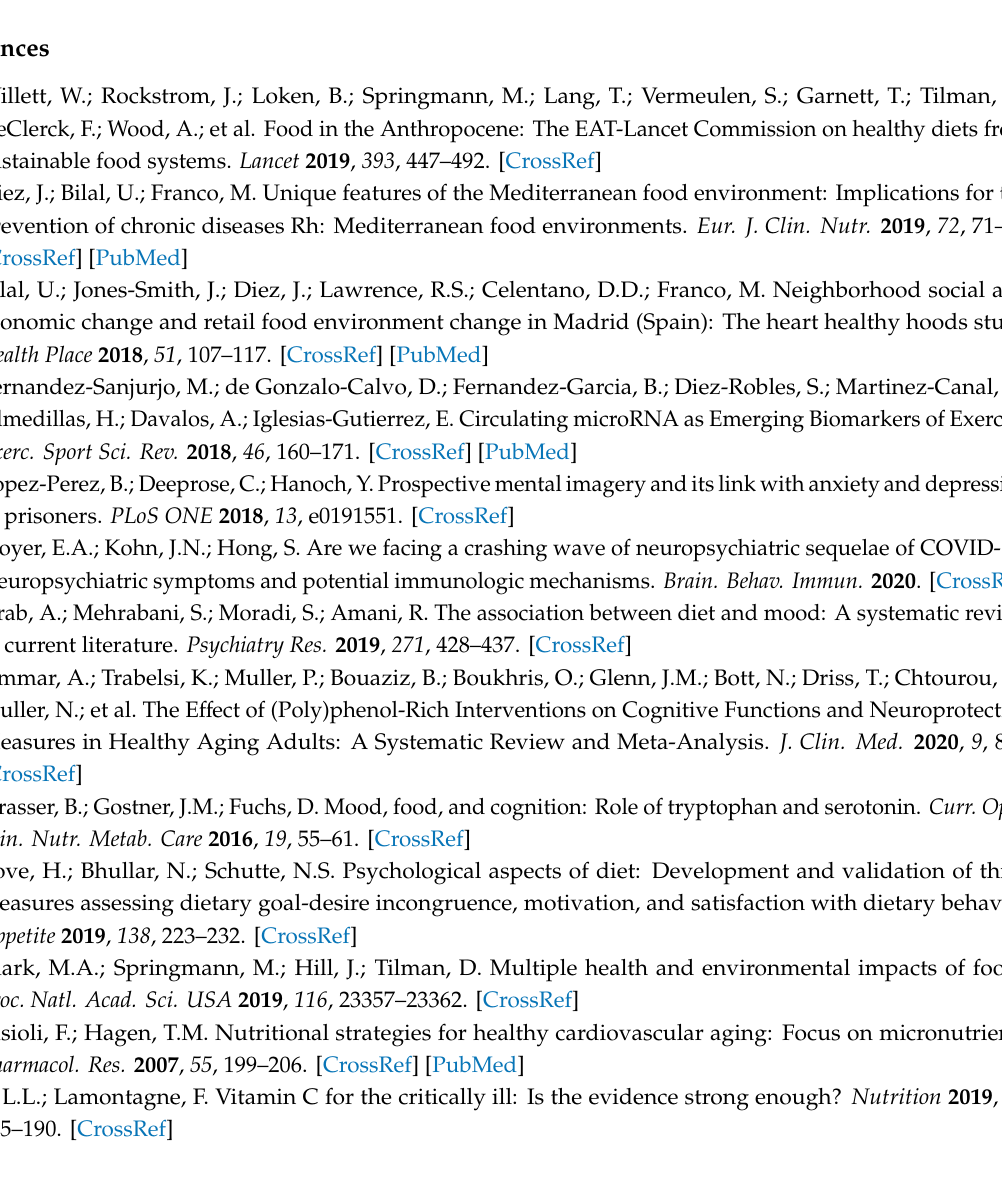
Figure S1: Results of the